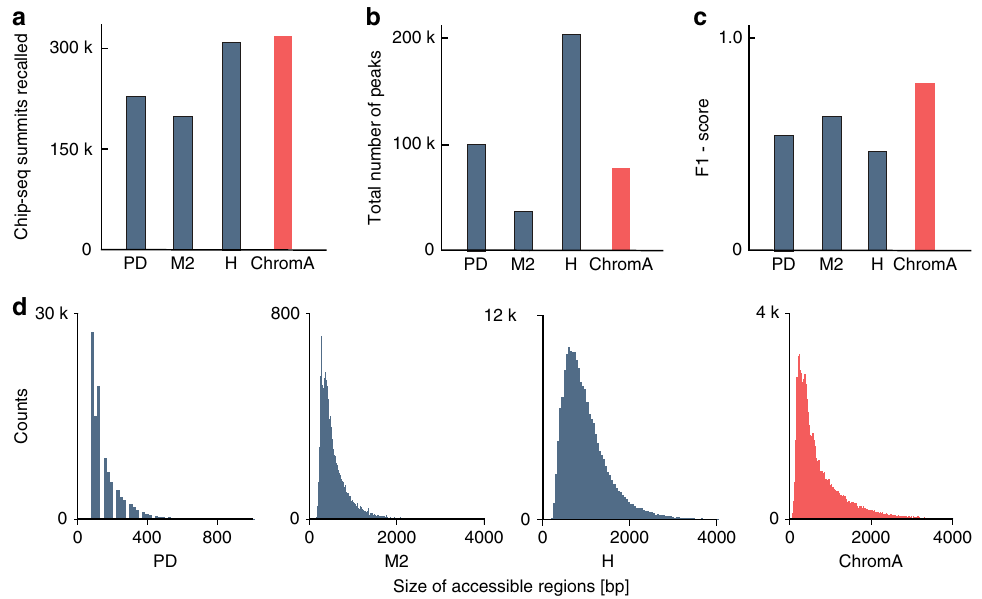
Fig. 3 Genome-wide validation of chromatin accessibility annotations. a – c ChromA effective genome-wide performance recalls the highest number of ChIP-seq calls maintaining a comparable number of peaks and controlling false positives. a The number of ChIP-seq-binding events recalled. b The total number of peaks annotated. c F1 score computed as the harmonic mean between precision and recall. d Distribution of accessible regions for different chromatin annotation algorithms. Histograms depicting the size of accessible chromatin regions annotated by PeaKDEck, MACS2, HMMRAtac, and ChromA. Posterior size distribution of ChromA ’ s accessible regions resembles a NB distribution, also observed in MACS2 and HMMRAtac. PeaKDEck distribution is highly dependent on algorithmic parameters, such as window size,